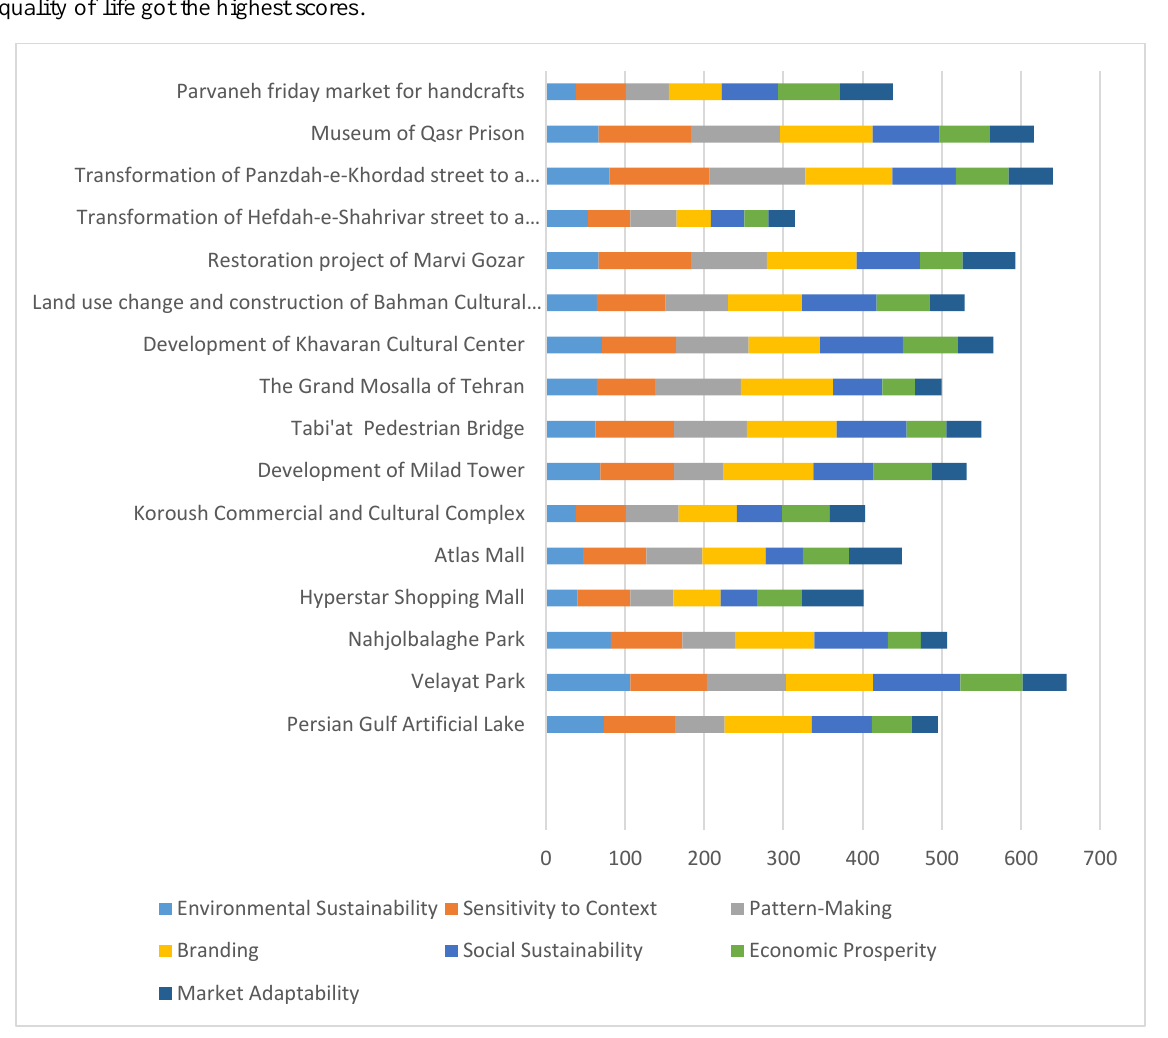
Figure 3. The scores of the selected projects/practices in Tehran according to the suggested evaluation criteria The large-scale projects show that despite the expected economic and social benefits of the development project of Persian Gulf Artificial Lake in the explanatory reports of Tehran Municipality, the project got low scores in market adaptability and economic prosperity criteria. Due to the new character, the project has made the City and the